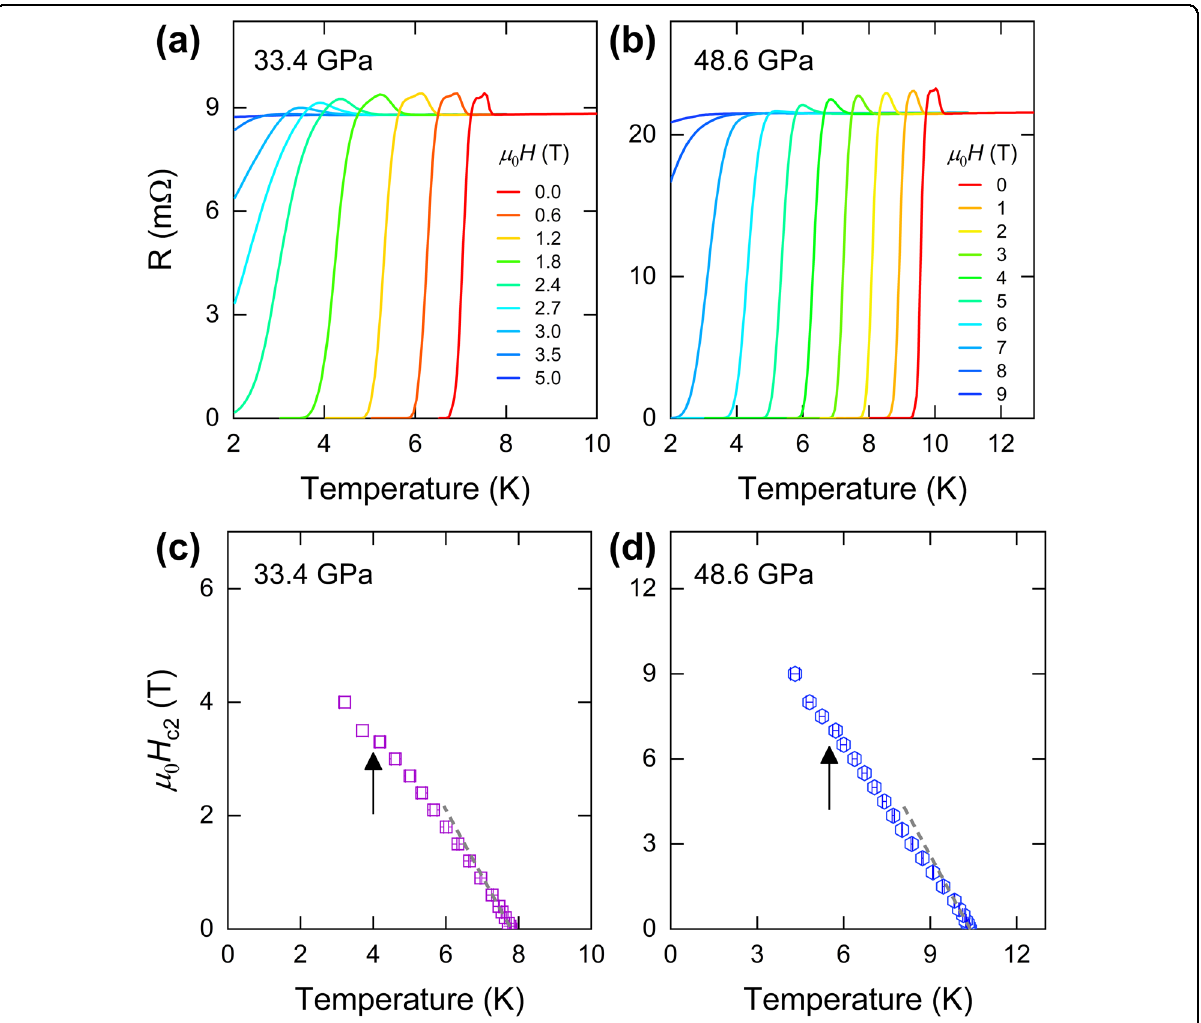
Fig. 2 Upper critical fi elds of Y under pressure. a Electrical resistance of Y as a function of temperature for representative magnetic fi elds at 33.4 GPa and b at 48.6 GPa. c Temperature dependence of the upper critical fi elds, μ 0 H c2 ( T ), at 33.4 GPa and d 48.6 GPa, where T c is determined to be the temperature at which the resistance deviates from normal-state behavior. We note that the T c onset is consistent with that determined from the PCS (see Fig. S4 in the Supplementary Information). The dashed lines indicate the initial slope of μ 0 H c2 ( T ) near T c . The arrows mark a kink in μ 0 H c2 ( T